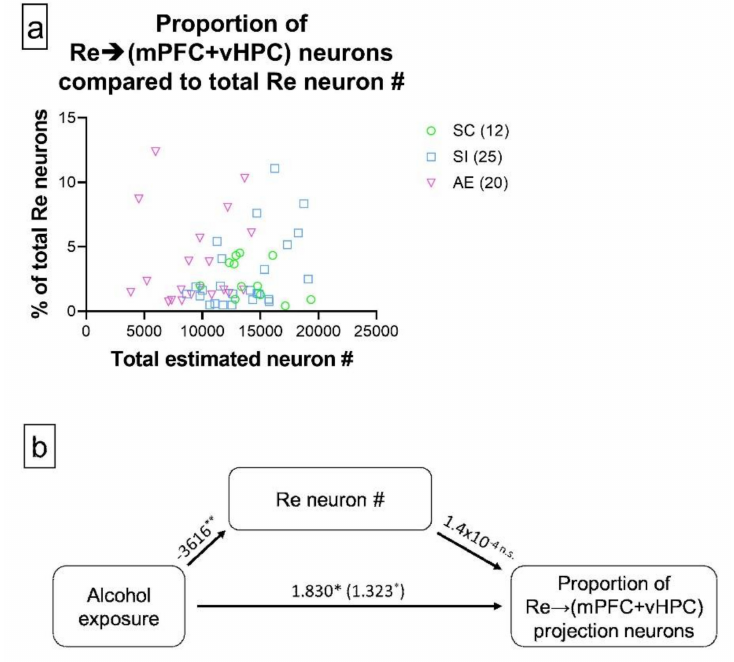
Figure 5. Neuron loss did not mediate the AE-induced increase in proportion of Re neurons that concurrently innervate mPFC and vHPC. ( a ) Scatterplot showing the relationship between total neuron number in Re and proportion of Re → (mPFC + vHPC) projection neurons; ( b ) Schematic repre- sentation of the mediation analysis between AE, Re neuron number, and proportion of Re → (mPFC + vHPC) projection neurons. The total effect of AE (in % of neurons) is shown in parentheses, while